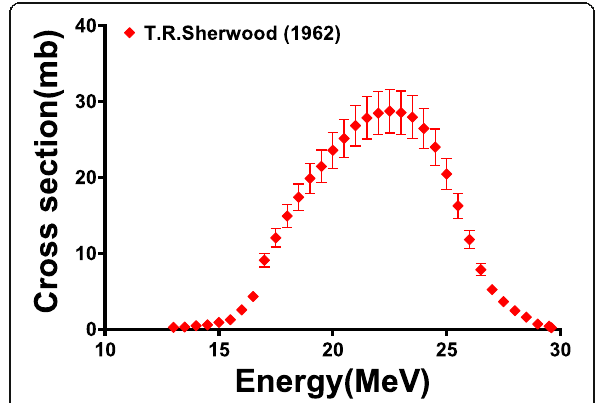
Fig. 1 The photonuclear cross section for the sum of the nat Ti( γ ,p) 47 Sc and nat Ti( γ ,np) 47 Sc nuclear reaction as a function of photon